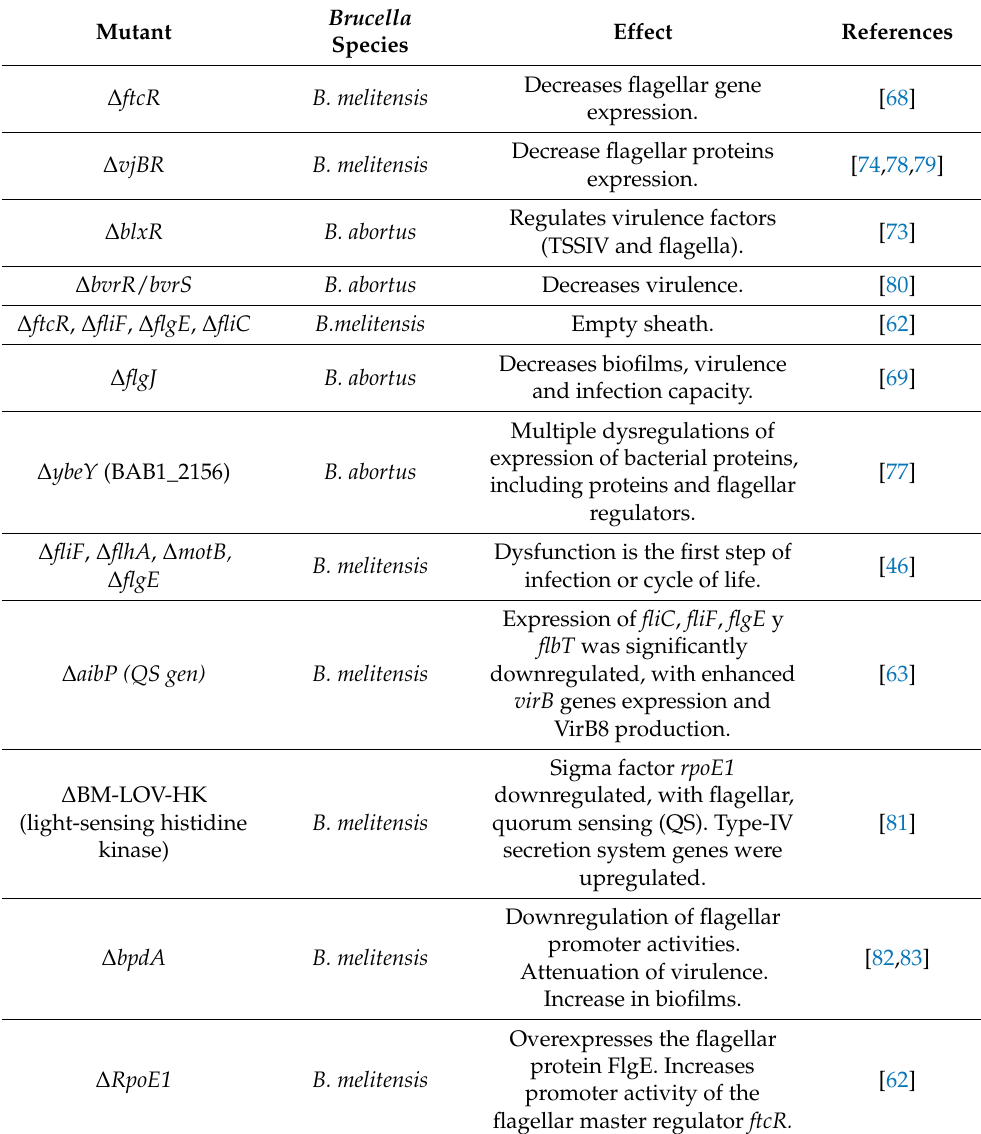
Table 2. Summary of the effects related to the mutation of genes encoding flagellar proteins or genes, related to their expression in Brucella